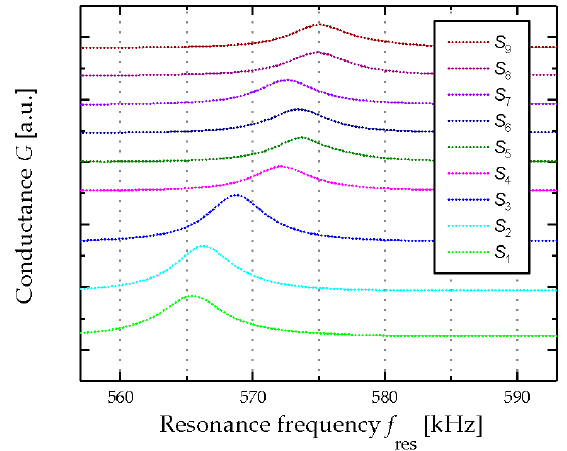
Figure 7. Electrical output characteristics of the piezoelectric MEMS resonator for a stuck fermentation process S 1 – S 9 , starting with S 1 at the bottom and all other model solutions ( S 2 – S 9 ) stacked above. The y -axis is scaled as arbitrary unit [a.u.].